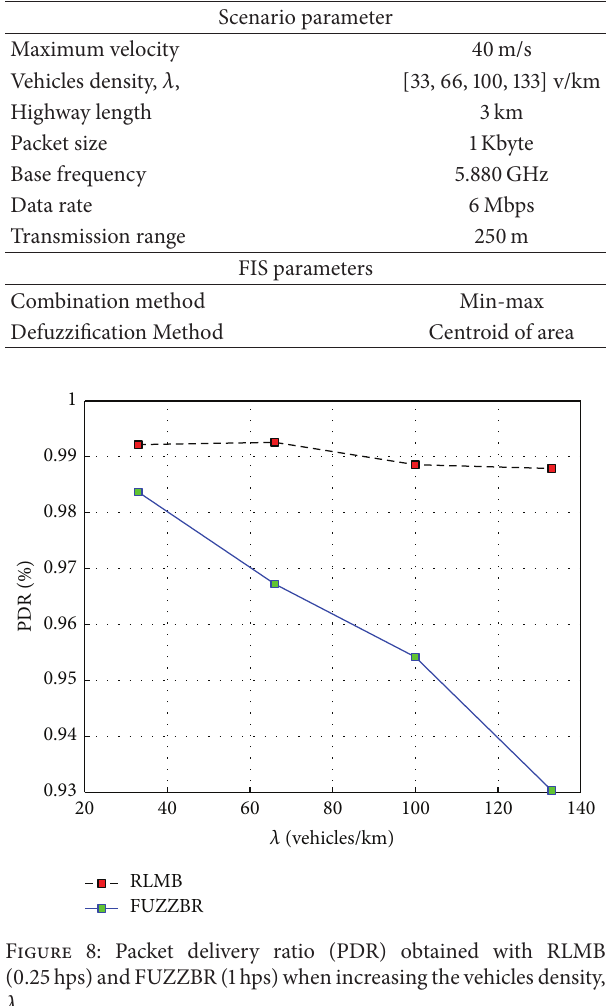
overhead is introduced with the consequent decrement in the number of collisions.